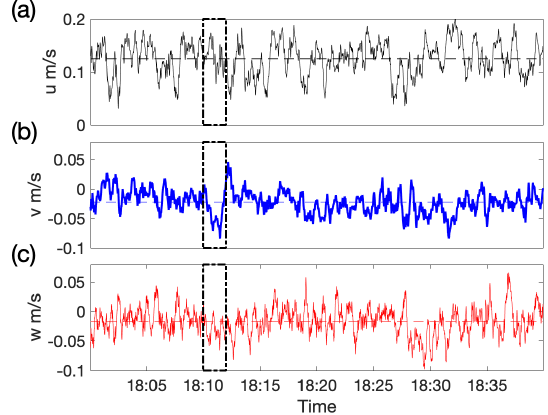
Figure 6. Running average flow speeds at 3.8m depth (averaged over 16s, which is two periods of natural vertical oscillation for the buoy) in (a) x , (b) y , and (c) z directions. The box indicates the time segment which corresponds with the sonar data in Fig. 5. u indicates the direction into the wind, v is the sideways axis to the port side, and w is the vertical direction, all in the buoy frame of reference. The dotted lines show the average of flow speed over this period (which are non-zero because of Stokes drift in the u direction and the buoy lean in the w direction). There is a notable sideways flow feature as the plume forms, and the vertical velocity at that time is generally downward, possibly indicating surface convergence in a Langmuir circulation flow